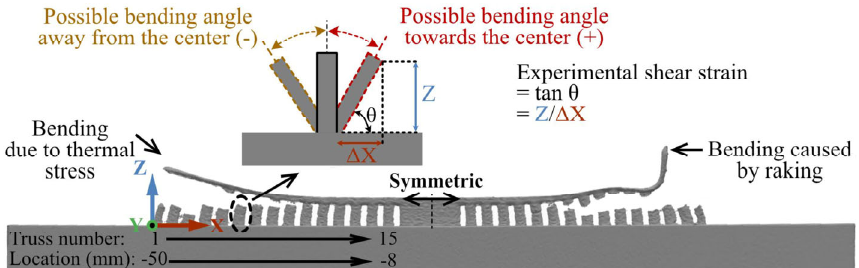
Figure 5. Three ‐ dimensional scanned unidirectional S0R180 part, showing the typical bending of Figure 5. Three-dimensional scanned unidirectional S0R180 part, showing the typical bending of the the supporting trusses. supporting trusses.